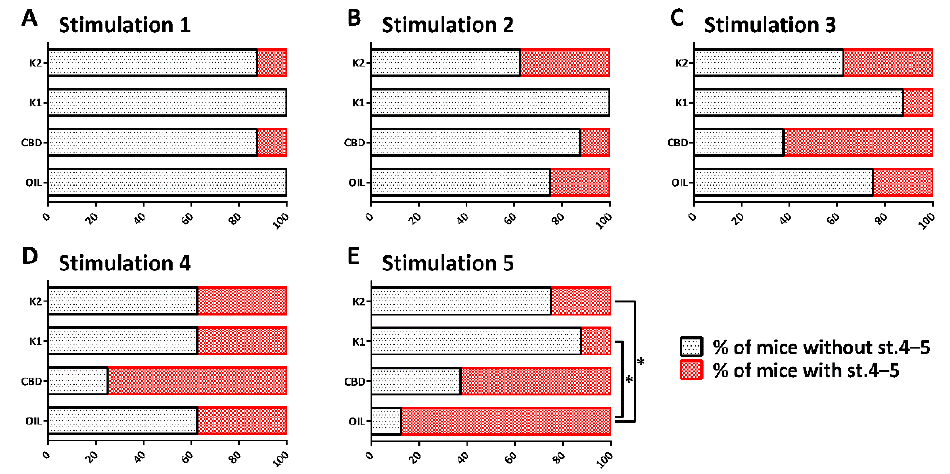
Figure 4. Percentage of mice developing (in red), or not developing (in black), generalized tonic– clonic convulsions, with (stage 5, st. 5) and without loss of posture (st. 4), after each session of 6-Hz corneal stimulation. The repeated 6-Hz test induced progressive changes in the seizure severity ( A – E ) and, at the end, the percentage of K1- and K2-treated mice developing st. 4–5 seizures was significantly reduced in comparison to olive oil-treated mice. * p < 0.050; Fisher’s exact test. OIL, olive oil; CBD, cannabidiol; K1, hemp oil 1; K2, hemp oil 2.